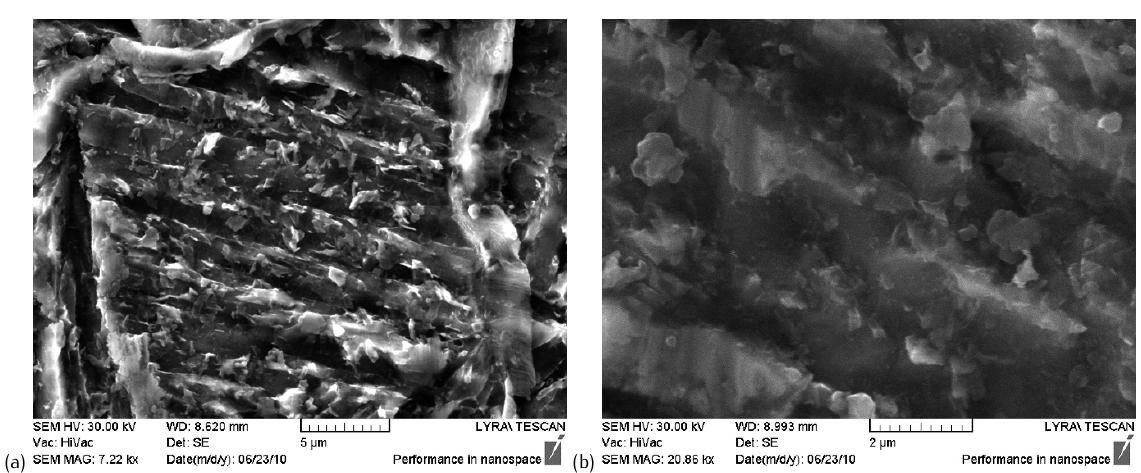
Figure 7. Carbide precipitations in the 18Cr2Ni4WA steel in different